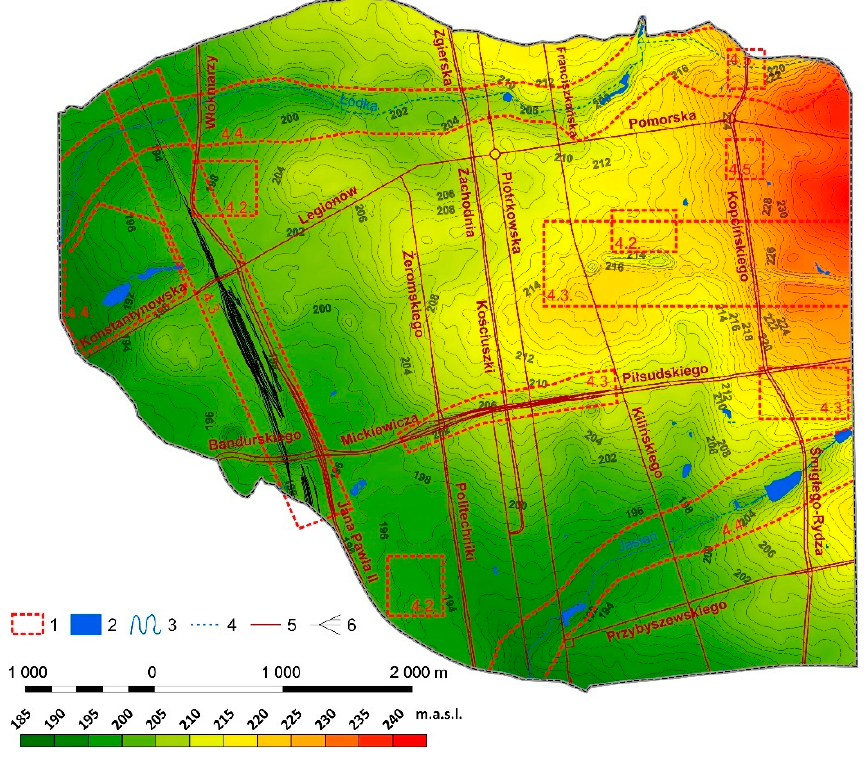
Figure 7. The relief of the modern land surface of a fragment of Ł ód ź based on generalised laser scanning data from 2017. 1—areas of detailed analysis, 2—waters, 3—surface watercourses, 4—underground watercourses, 5—main streets, 6—railway tracks (situation in 2017). Source: Own study.